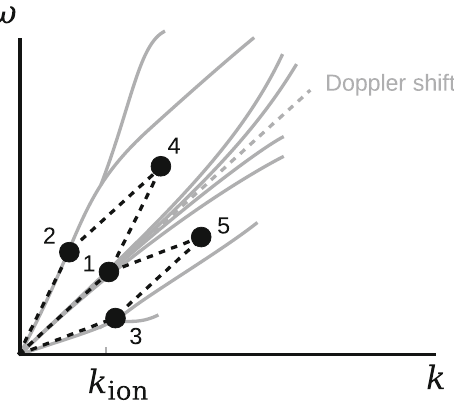
Fig. 7 Three-wave couplings in the dispersion relation diagram (parallelograms in the wavenumber–frequency domain) superposed onto the ion-kinetic wave modes. The initial waves (1, 2, and 3 in the digram) interact and generate the wave 4 and the wave 5 through the coupling of the waves 1 and 2, and that of the waves 1 and